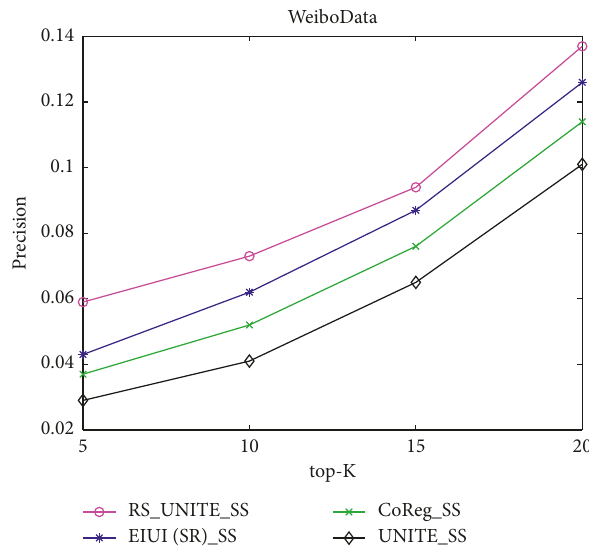
Figure 3: Comparison of methods based on user interest behavior prediction accuracy on